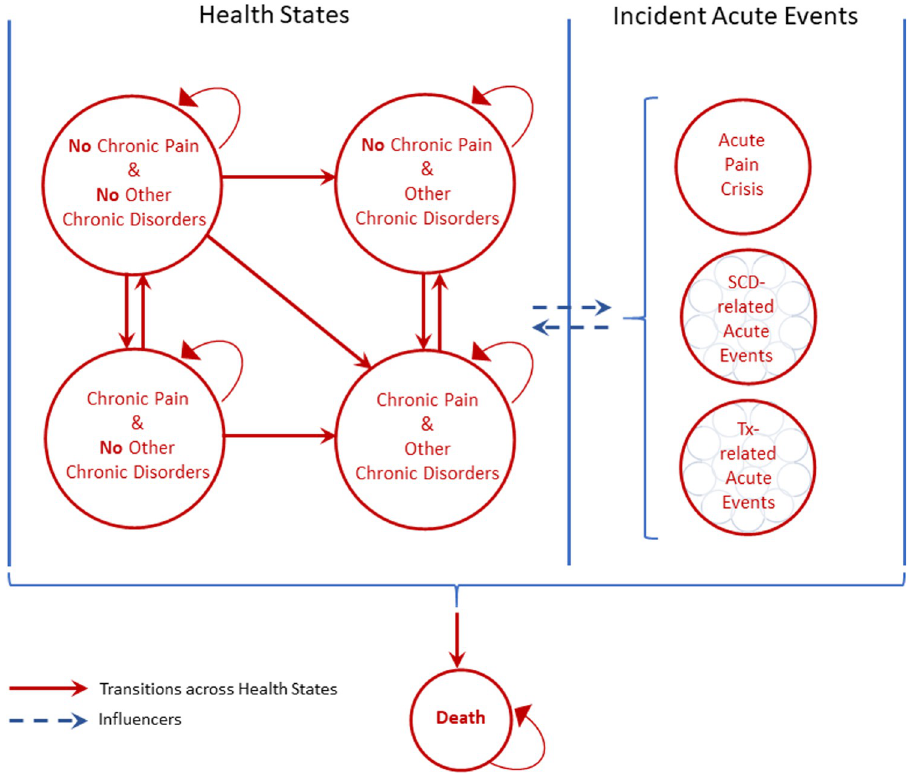
Fig 2. Diagram of the conceptual model of SCD. Treatment (Tx)- related acute events are leukopenia, thrombocytopenia, and oligospermia/azospermia associated with hydroxyurea; iron overload, transfusion reaction and infection associated with transfusion; graft versus host disease, graft failure, bronchiolitis obliterans, osteoporosis, iron overload, depression, posterior reversible encephalopathy syndrome, post-transplant lymphoproliferative disorder, and secondary malignancy associated with HSCT; and graft failure, bronchiolitis obliterans, osteoporosis, iron overload, depression, posterior reversible encephalopathy syndrome, post-transplant lymphoproliferative disorder, and secondary malignancy associated with genetic